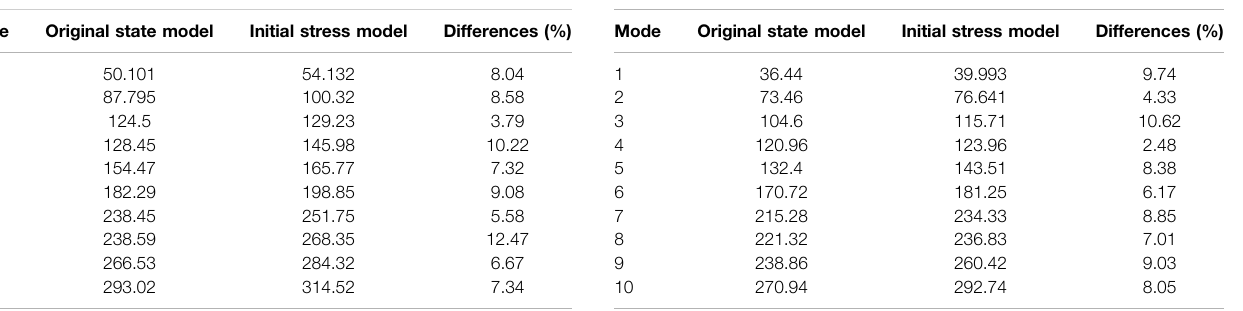
TABLE 7 | Natural frequencies with fi xed boundary conditions (Hz). TABLE 8 | Natural frequencies with simply supported conditions